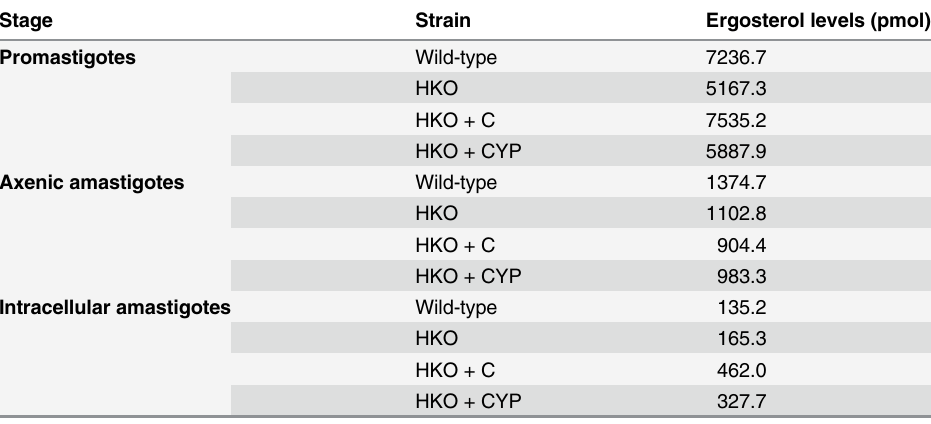
Table 1. Ergosterol levels in half knockout